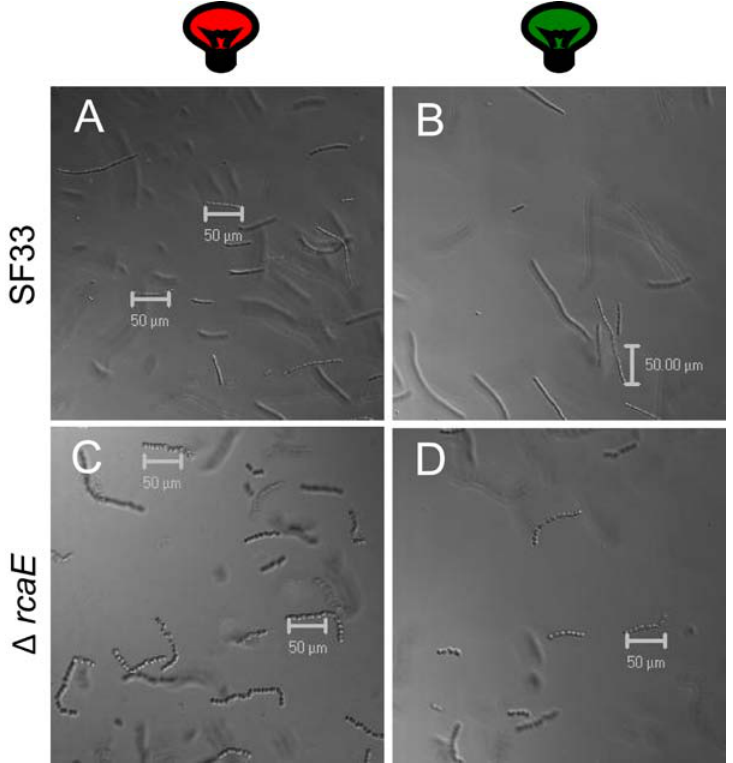
Figure 2. Differential Interference Contrast (DIC) images of filament populations of Fremyella diplosiphon strains grown in broad-band red and green light. Wild-type pigmentation SF33 (A, B) and Δ rcaE mutant (C, D) strains. Images at 20× dry objective. Bars, 50